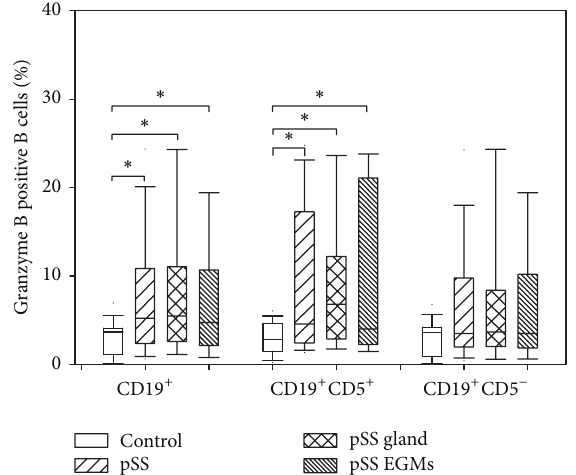
Figure 1: Granzyme B expression of B cell subsets. Box plots show median, upper, and lower quartiles; lines extending vertically from boxes indicate 5–95 percentile ranges. Statistically significant differences are indicated by ∗ .